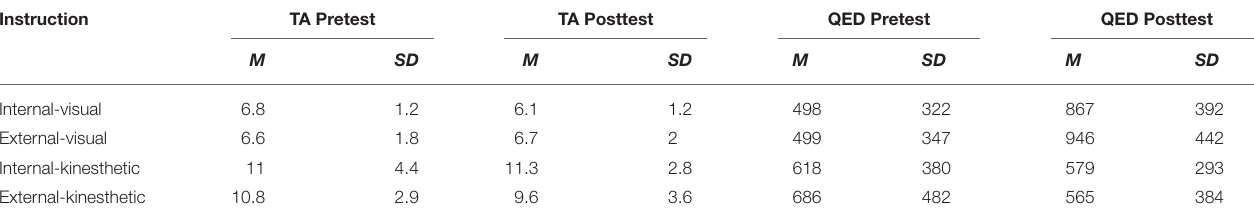
TABLE 3 | Mean scores (M) and standard deviation (SD) for the different groups in throwing accuracy (TA) and quiet eye duration (QED). Instruction TA Pretest TA Posttest QED